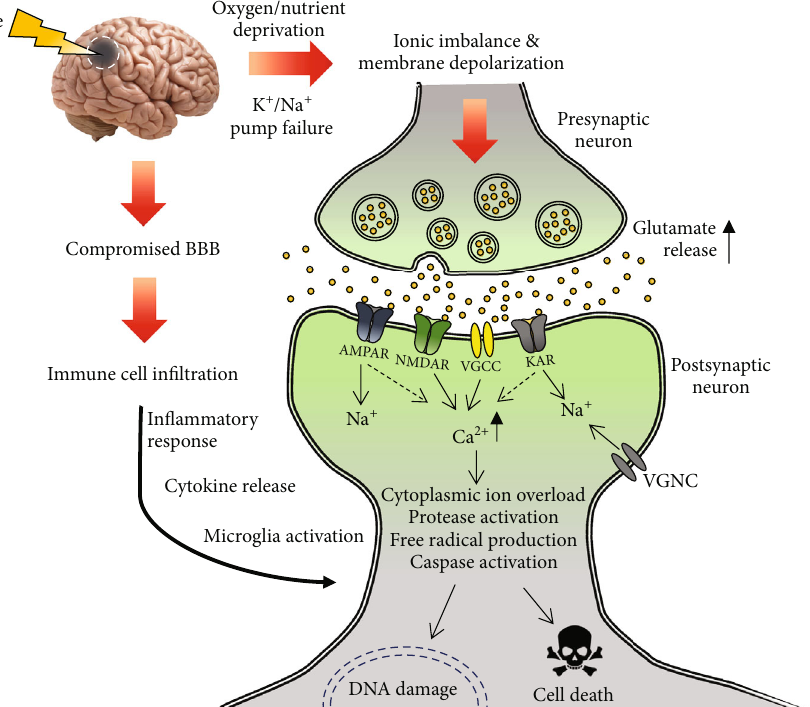
Figure 1: A schematic diagram depicting the pathogenesis of stroke in neurons. Upon the onset of stroke, reduced oxygen and nutrient supplies rapidly lead to the failure of ATP-dependent Na + /K + pumps causing ionic imbalance and cell membrane depolarization, resulting in presynaptic overrelease of neurotransmitters including glutamate into the synaptic cleft. Activation of postsynaptic glutamate receptors AMPAR, NMDAR, and KAR leads to large volume Na + and Ca 2+ in fl uxes, further cell membrane depolarization of the postsynaptic neuron, and opening of the membrane potential-sensitive VGNCs and VGCCs. This allows even more Na + and Ca 2+ to fl ow into the cell which causes cytoplasmic ion overload, protease activation, production of free radicals, caspase activation, and eventually DNA damage and neuronal cell death. Meanwhile, as the BBB is compromised during stroke, immune cells from the blood start to in fi ltrate the brain to elicit in fl ammatory responses, such as cytokine release and microglial cell activation, which further exacerbate the brain damage and injury. BBB: blood-brain barrier; AMPAR: α -amino-3-hydroxy-5-methyl-4-isoxazolepropionic acid receptor; NMDAR: N -methyl-D- aspartic acid receptor; KAR: kainic acid receptor; VGCC: voltage-gated calcium channel; VGNC: voltage-gated sodium channel.